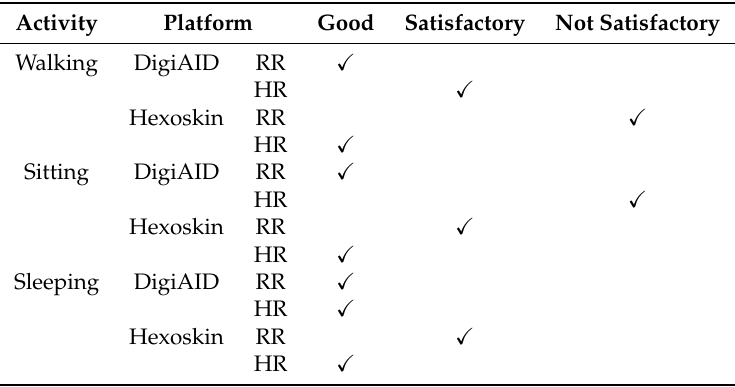
Table 2. Comparison between DigiAID and